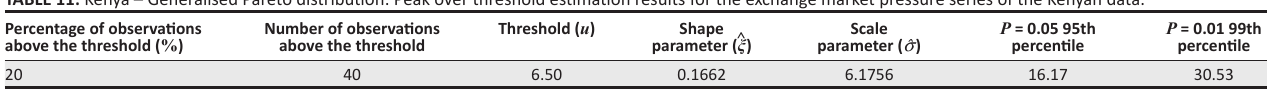
Percentage of observations above the threshold ( %